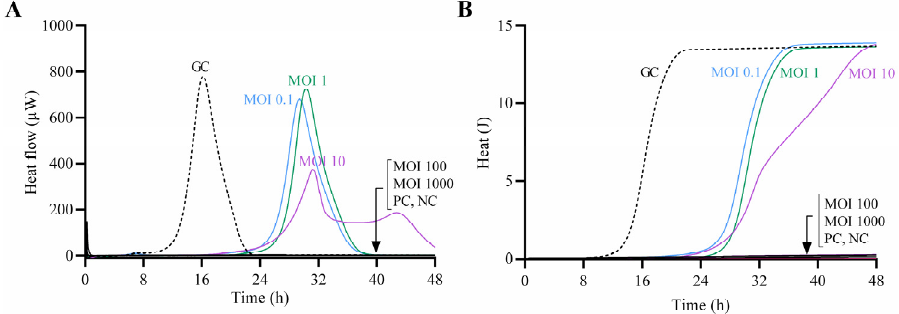
Figure 4. Calorimetric curves. Monitored heat-flow ( A ) and heat ( B ) production of planktonic S. maltophilia STM-19 (10 5 CFU/mL) co-incubated with phage CUB19 at different MOI. GC, growth control; PC, phage control; NC, negative control. Data of a representative experiment are reported.